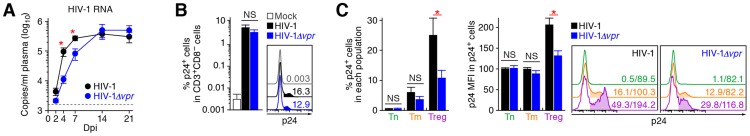
Dynamics of R5 WT and vpr-deficient HIV-1 infection in humanized mice.(A) Viral load in infected humanized mice. The amounts of viral RNA in the plasma of R5 WT HIV-1-infected mice (n = 30) and R5 vpr-deficient HIV-1-infected mice (n = 23) were routinely quantified. The horizontal broken line indicates the detection limit of the assay (1,600 copies/ml). (B and C) Infected cells in humanized mice. HIV-1-infected cells in the spleen of R5 WT HIV-1-infected mice (n = 19), R5 vpr-deficient HIV-1-infected mice (n = 10), and mock-infected mice (n = 10) at 7 dpi were analyzed by flow cytometry using an anti-HIV-1 p24 antibody. The percentages of p24+ cells in CD3+ CD8− cells (B) and in each CD4+ T cell subset (C, left panel), and the MFI of p24 in p24+ cells of each CD4+ T cell subset (C, middle panel) are shown. Representative histograms are shown on the right panel. In panel B, the numbers in the histogram indicate the positivity. In panel C, the numbers in the histogram indicate the percentage of positive cells (left) and MFI values (right). Statistical difference was determined by Welch's t test, and statistically significant differences between WT HIV-1 versus HIV-1Δvpr (P<0.05) are shown with red asterisks. NS, no statistical significance. Data represent mean ± SEM.